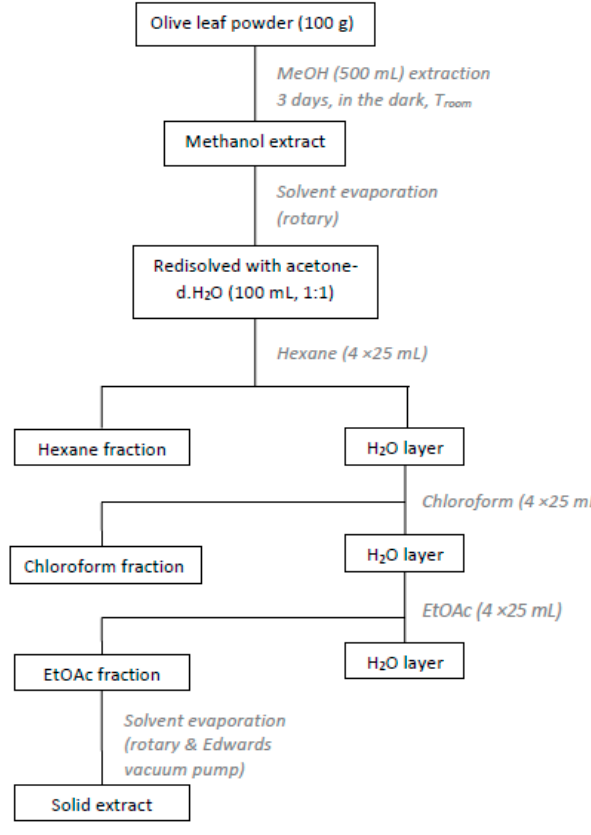
Figure 1. Experimental procedure for the preparation of olive leaves extract (OLE).